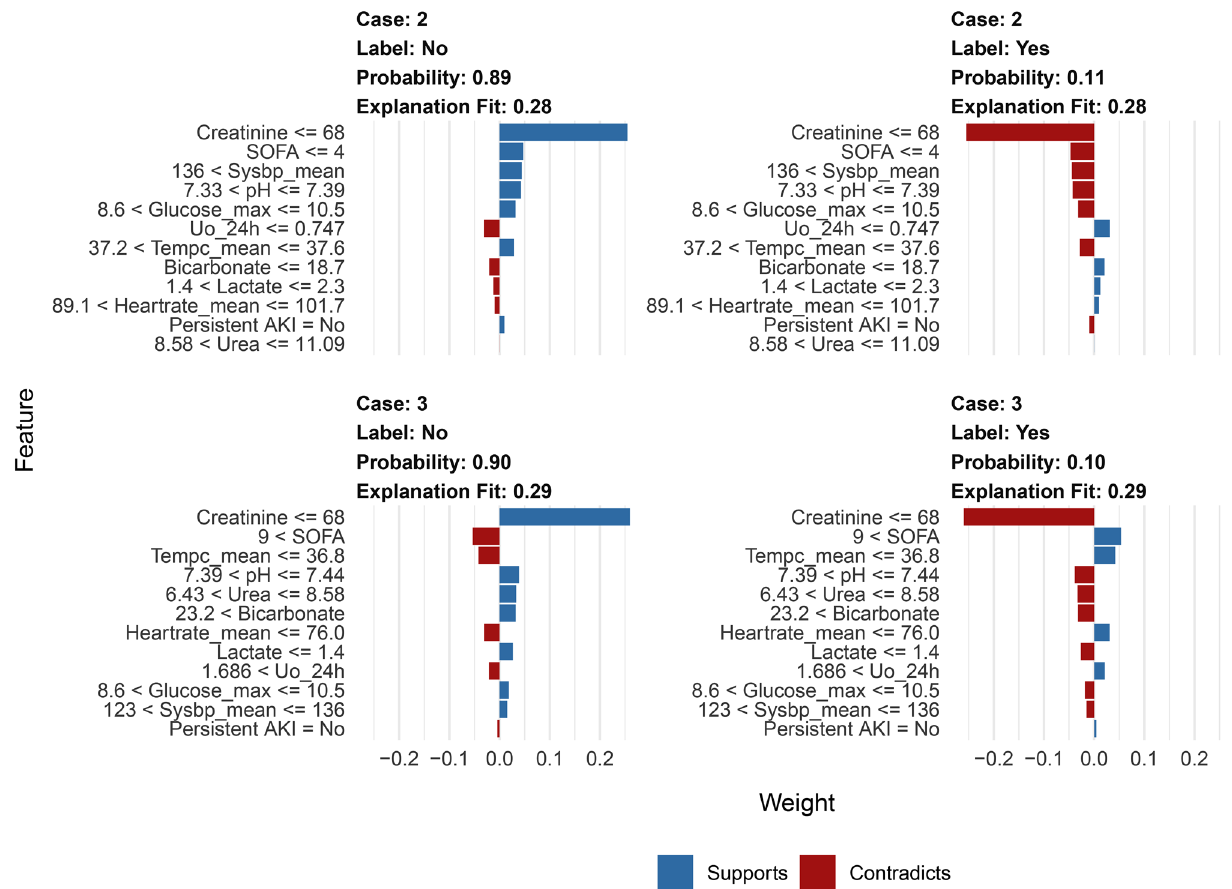
Figure 6. The LIME feature plot shows the contribution of each variable to the classification of the sample patients. The red colour indicates that the relevant variable contradicts a given label, while the blue colour indicates support. AKI, acute kidney injury; SOFA, Sepsis-related Organ Failure Assessment; Uo_24h, Urine volume for 24 h on intensive care unit admission; LIME, Local Interpretable Model-Agnostic